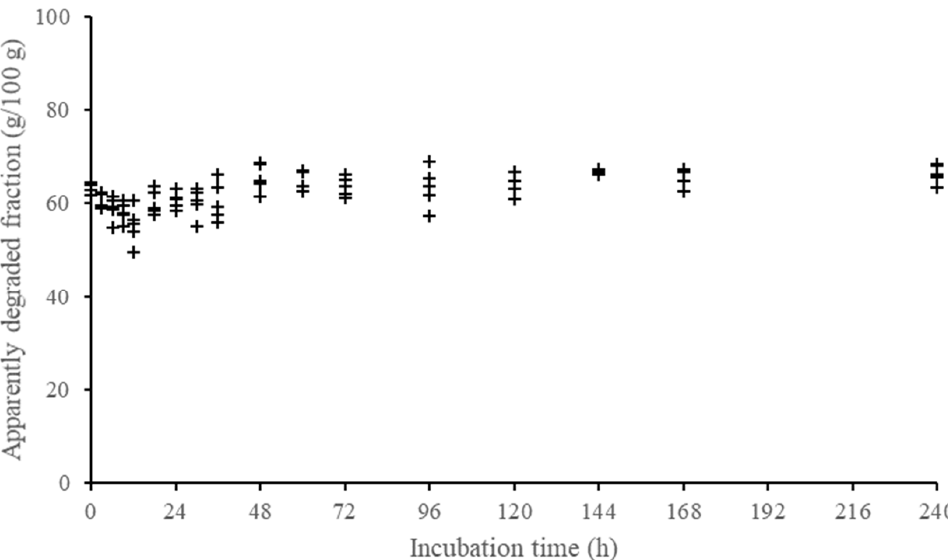
Figure 1. Descriptive pattern of the apparently degraded fraction of crude protein of a forage sample (sugarcane) according to incubation time (each point within incubation time represents one different animal).